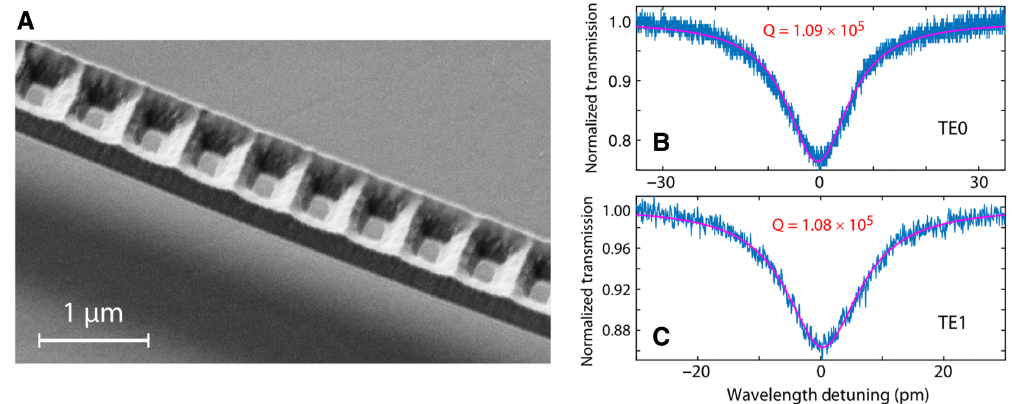
Figure 12: LNOI photonic crystal nanocavities. (A) Scanning electron microscope image of an LN photonic crystal nanobeam. (B, C) Measured Q factors of the fundamental (TE0) and second-order (TE1) cavity modes. Reprinted with permission from Liang et al. [41]. © The Optical